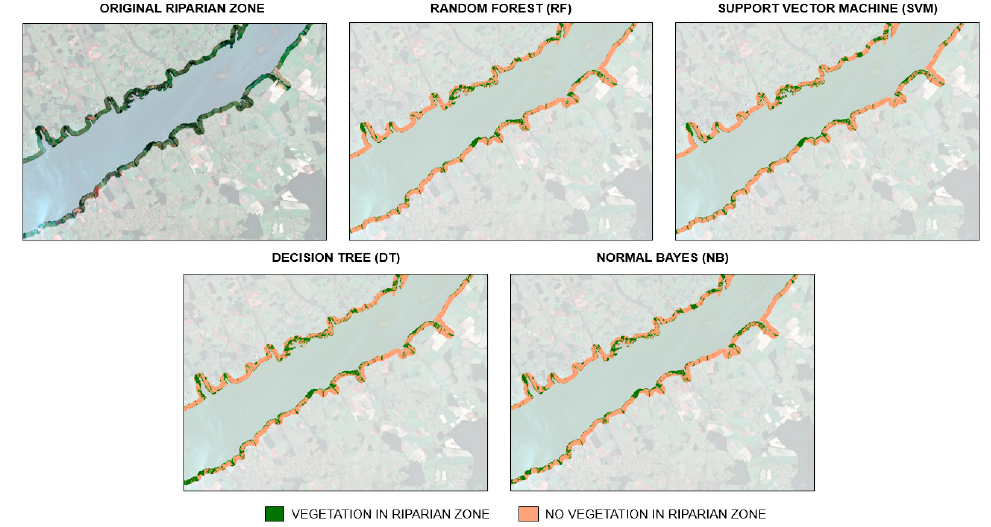
Figure 5. Results of the image classifications of each